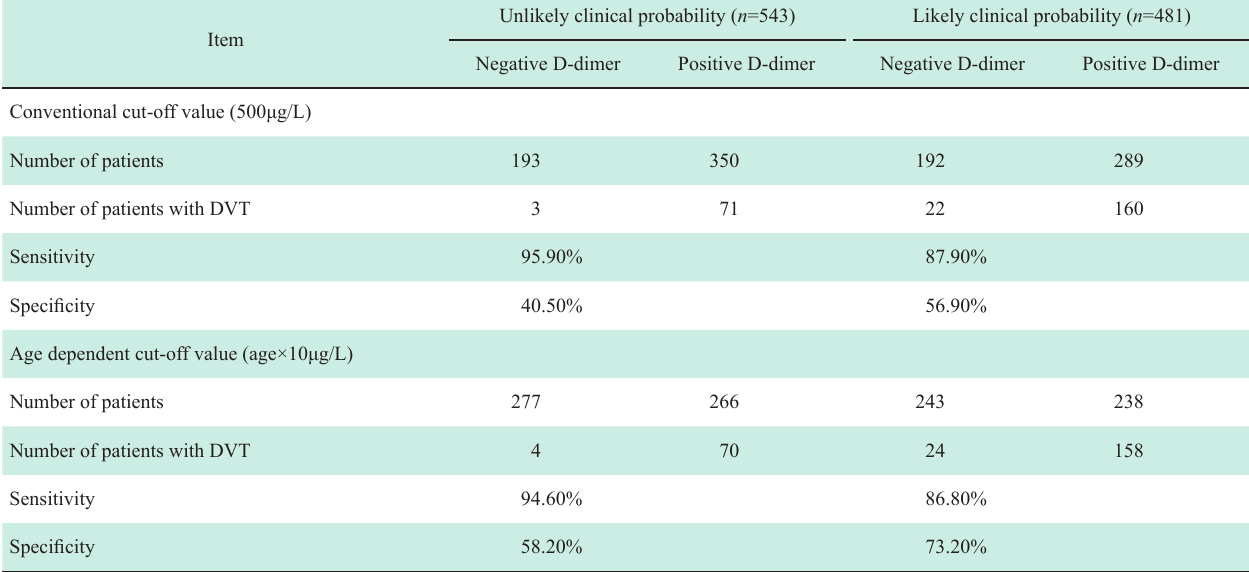
Table 3 Two D-dimer cut-off values combined with Wells score in diagnosing and excluding DVT